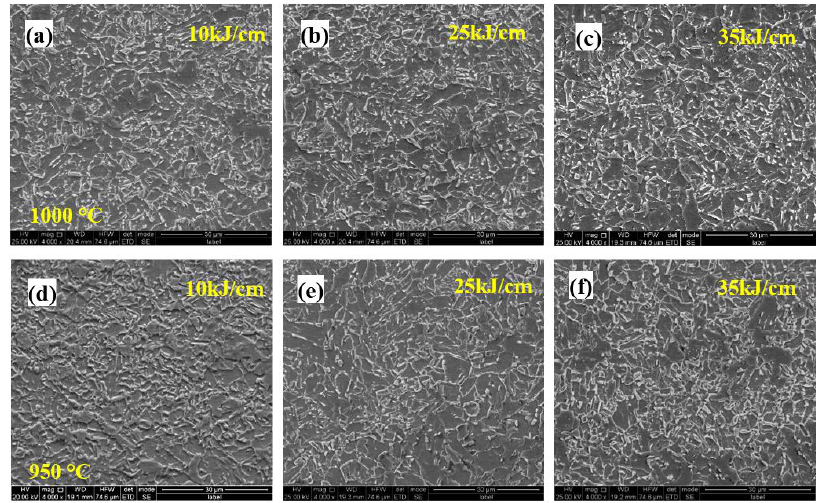
Figure 9. Microstructure of FGHAZ with 0.089% Nb content under various heat input and peak temperature: ( a ) 10 kJ/cm at 1000 ◦ C; ( b ) 25 kJ/cm at 1000 ◦ C; ( c ) 30 kJ/cm at 1000 ◦ C; ( d ) 10 kJ/cm at 950 ◦ C; ( e ) 25 kJ/cm at 950 ◦ C; ( f ) 30 kJ/cm at 950 ◦ C.